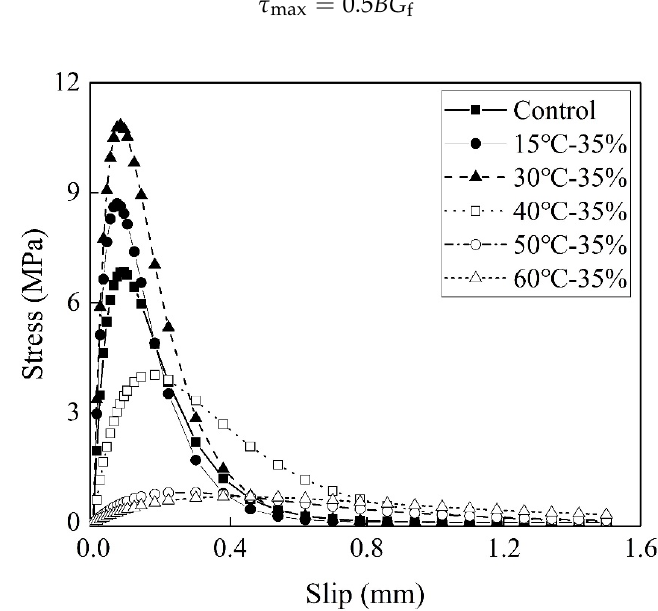
Figure 6. Bond stress–slip relationship.